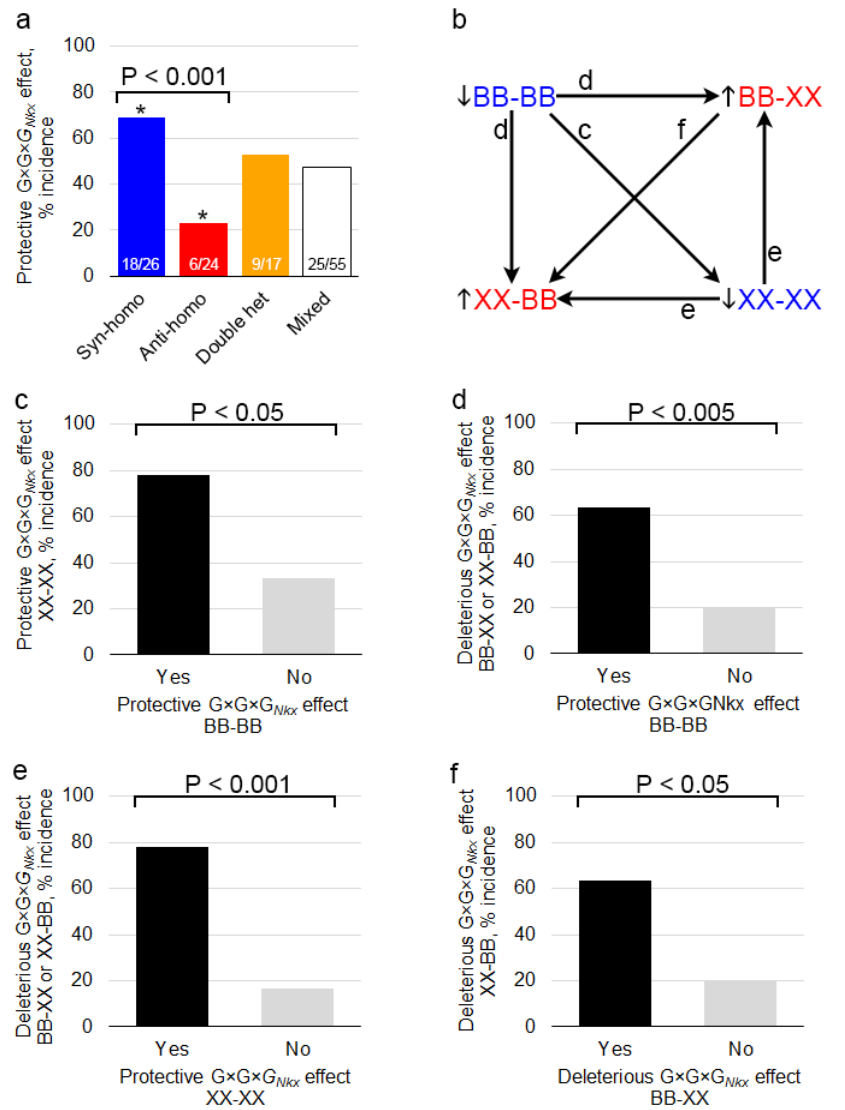
Figure 4. Genetic compatibility between the two loci in a G × G × G Nkx interaction lowers the risk of heart defects in Nkx2-5 +/ − mice. ( a ) Statistically significant syn-homozygous G × G × G Nkx effects between two modifier loci are more likely to be protective than expected by chance or compared to anti-homozygous effects. Anti-homozygous effects are less likely to be protected than expected by chance. Double-heterozygous and mixed genotype effects are equally likely to be protective or deleterious. The fractions of significant effects that are protective are indicated. *, not equal to 50%, P < 0.05. ( b ) A significant G × G × G Nkx effect at a syn-homozygous genotype that is protective (risk ↓ ) or at an anti-homozygous genotype that is deleterious (risk ↑ ) is associated with congruent effects at the other syn- and anti-homozygous genotypes, as shown in ( c ) to ( f ). ( c ) A protective BB–BB genotype is associated with a protective XX–XX genotype from the other strain in the